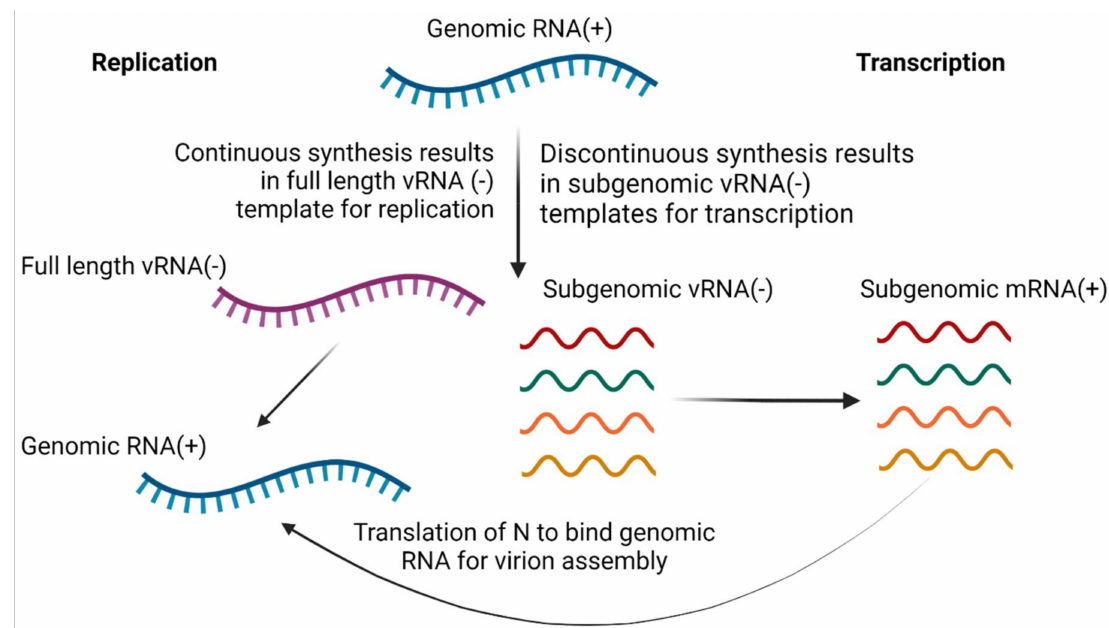
Figure 7. Coronavirus transcription and replication. The coronavirus replicase employs discontinuous synthesis to make a set of subgenomic vRNAs of negative sense from the viral positive-sense RNA genome. The subgenomic vRNAs serve as a template for transcription of subgenomic viral mRNAs. The replicase also synthesizes continuous full-length negative-sense vRNAs, which serve as a template for replication of genomic RNAs. Created with